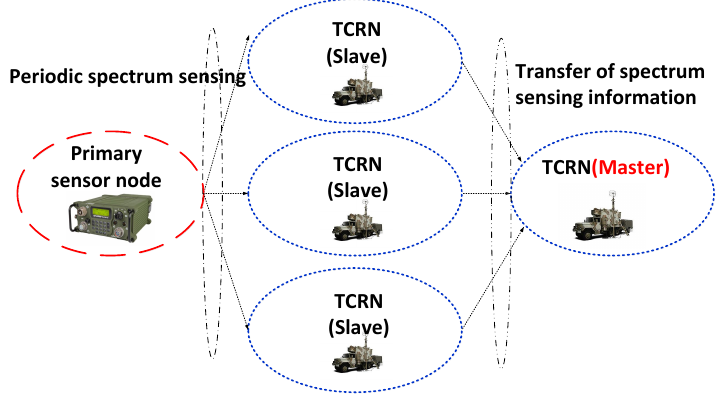
Figure 8. Simulation scenario environment. TCRN, tactical cognitive radio node.